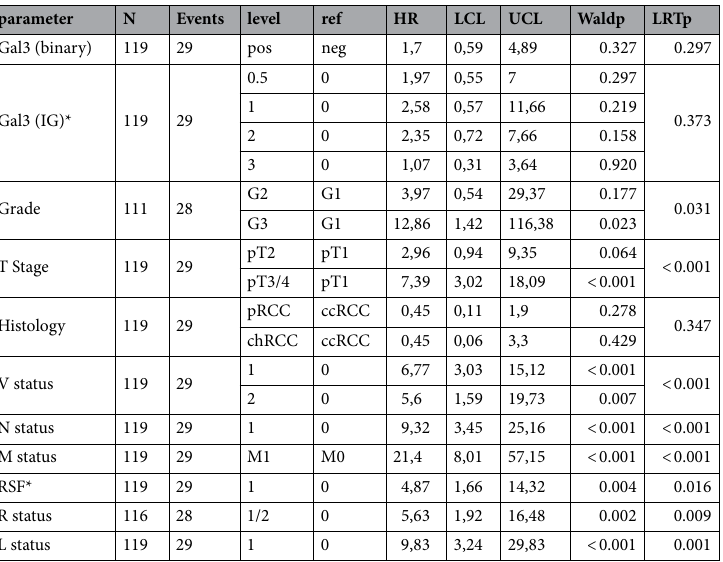
Table 4. Univariable Cox regression on progression-free survival. * IG intensity grade, RSF renal sinus fat infiltration, HR hazard ratio, LCL/UCL lower/upper 95% confidence limits, Waldp p-value of Wald test, LRTp p-value of likelihood-ratio test.